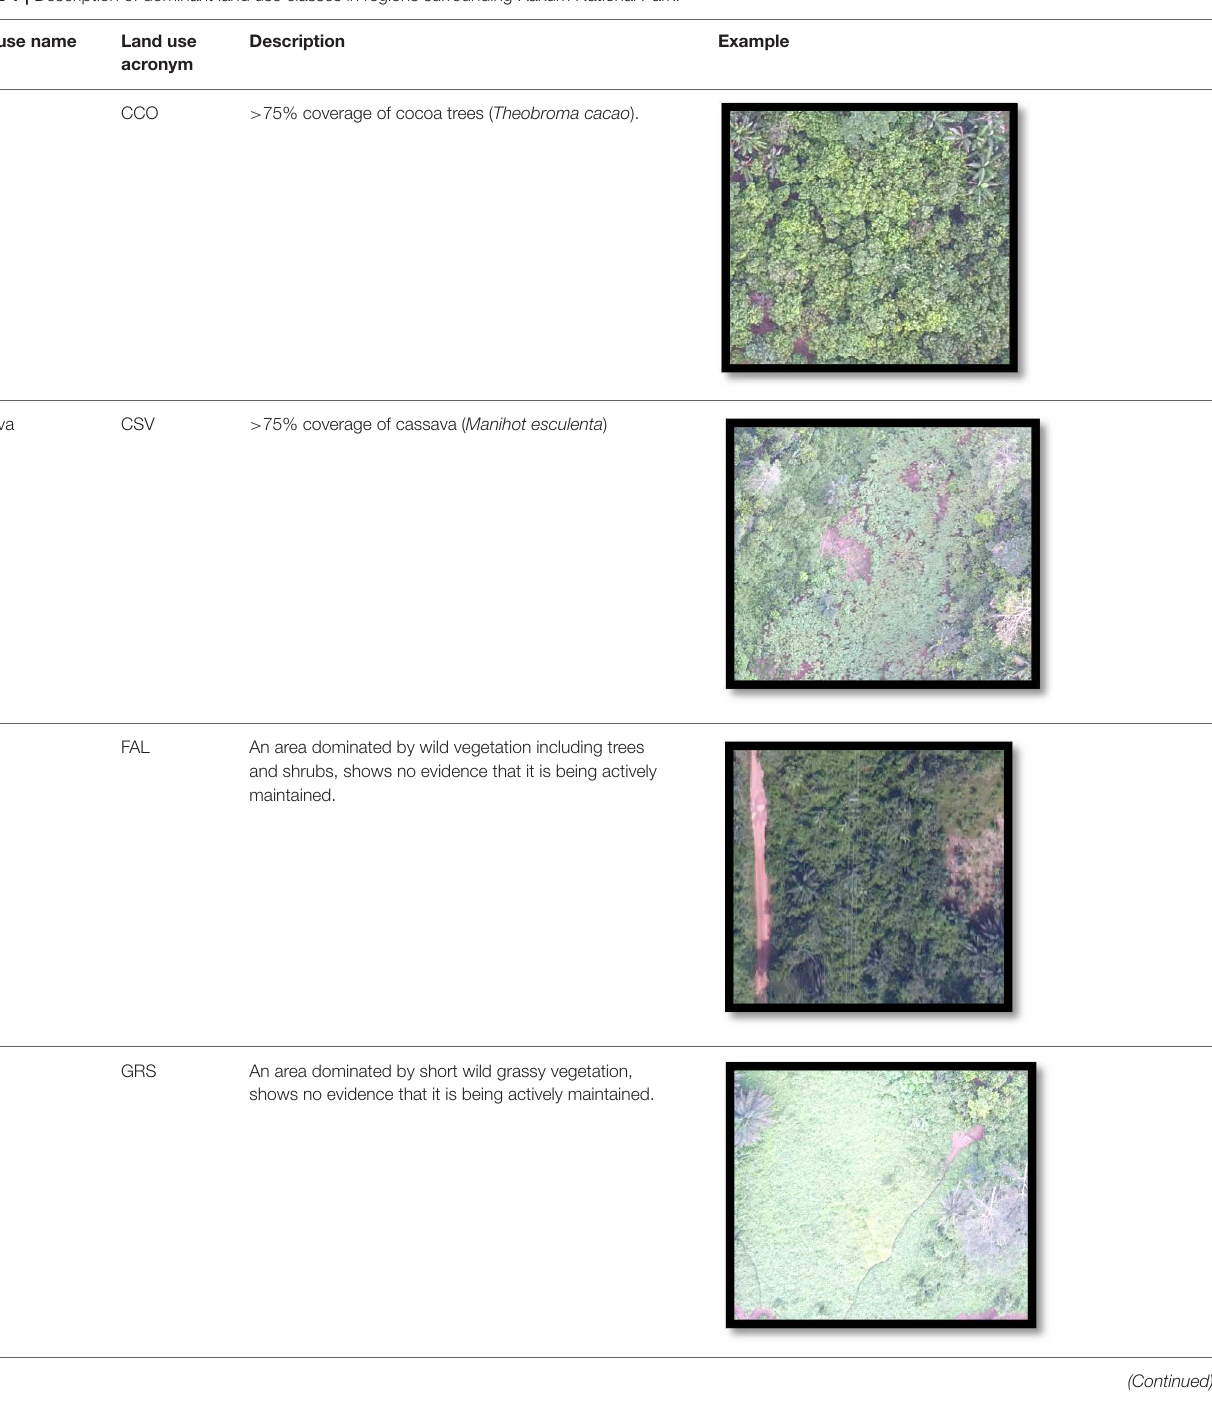
TABLE 1 | Description of dominant land use classes in regions surrounding Kakum National